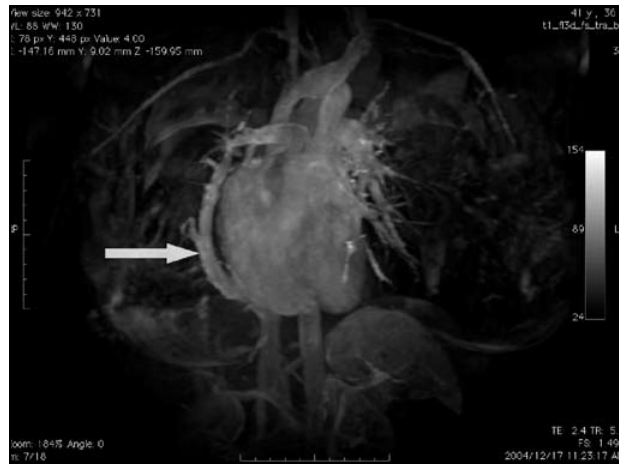
Fig. 6. Contrast-enhanced MR angiogram of a patient with Scimitar syndrome. Note the anomalous drainage of the right inferior pulmonary vein into the supra-hepatic IVC via the scimitar vein (block